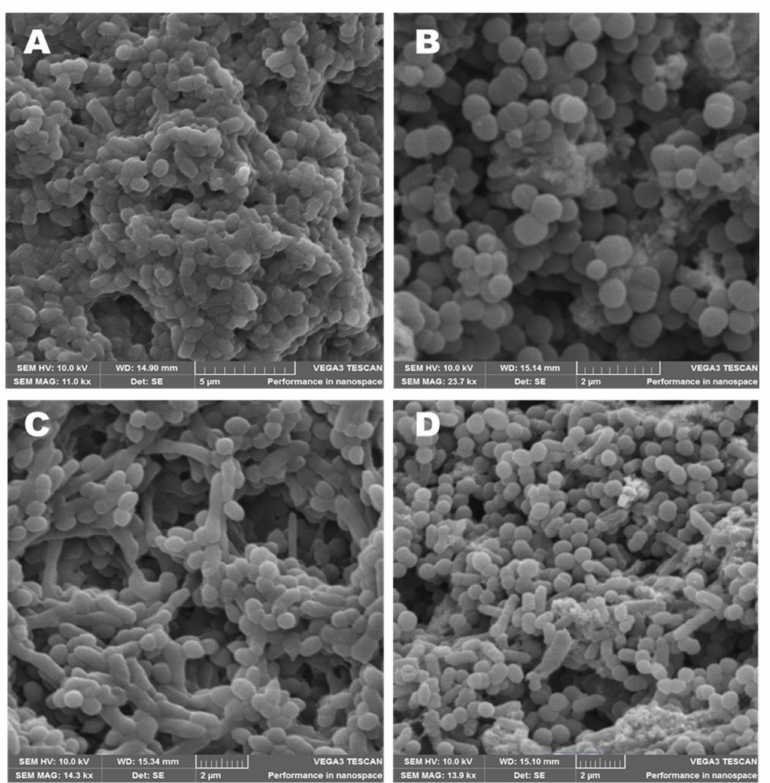
Figure 8. SEM images of ( A ) S. aureus after incubation with 62.5 µ g/mL of 1 mL CE AuNPs, ( B ) S. aureus and ( C ) K. pneumoniae after incubation with 62.5 µ g/mL of 1 mL CE AuNPs, and ( D ) K. pneumoniae